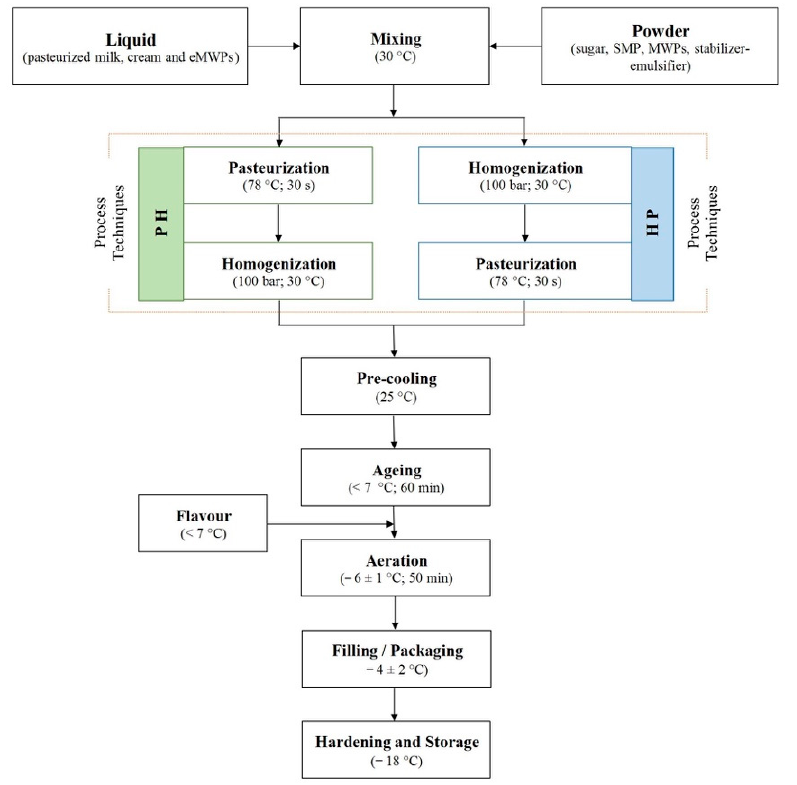
Figure 1. Flow chart of ice cream manufacturing with consideration of process design.